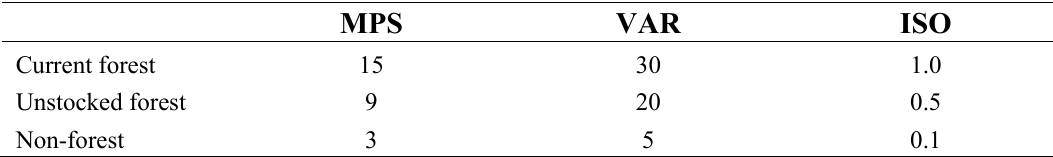
Table 4. Parameters for the expander and patcher transition